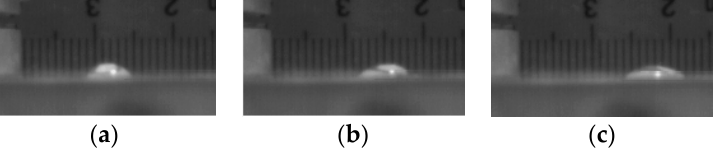
Figure 17. The movement characteristic of droplet under DC negative polar power source. ( a ) Droplet without applied voltage ( b ) droplet begin to add voltage ( c ) droplet with voltage of 10 kV.